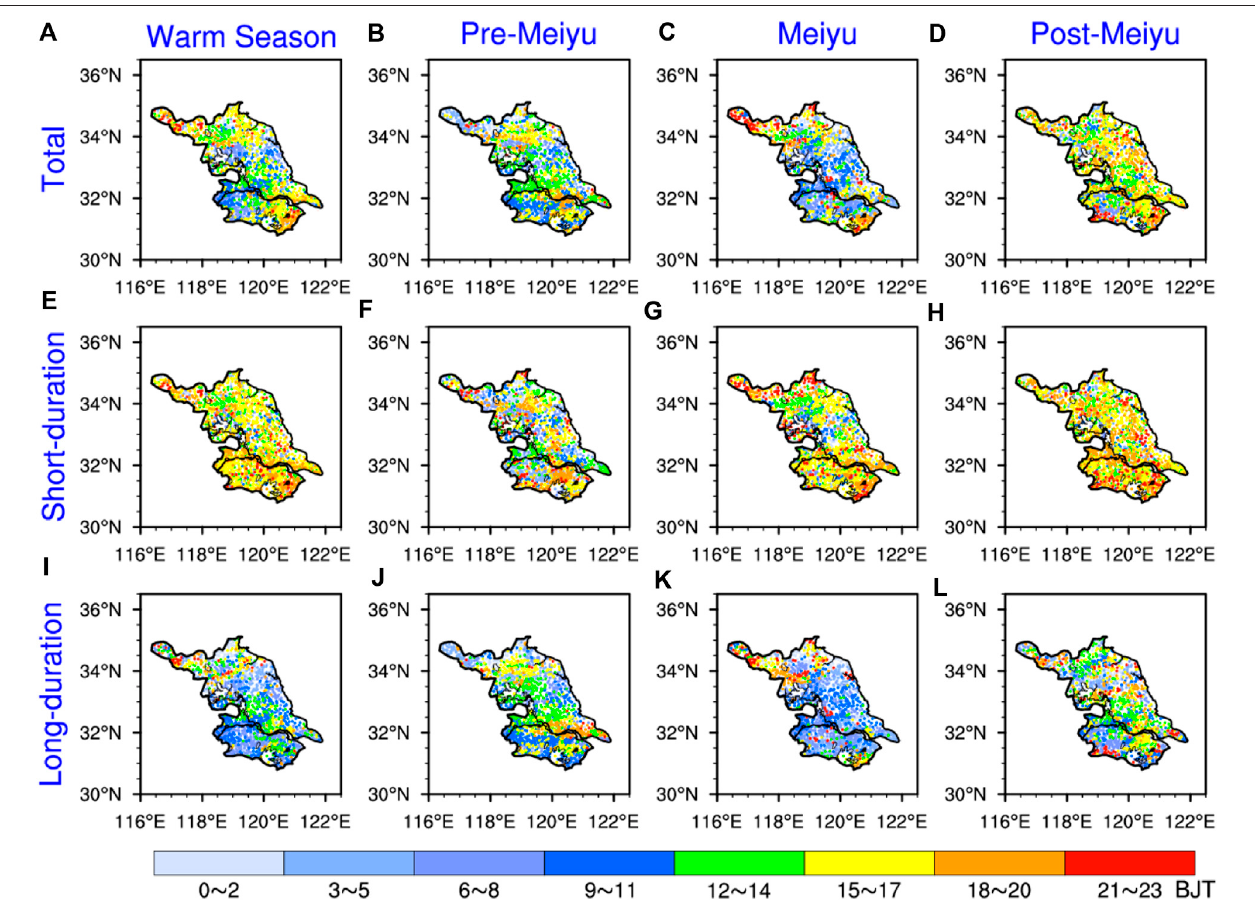
FIGURE9| SpatialdistributionsofthediurnalpeaktimeofPAfortotalrainfall (A-D) ,short-durationrainfall (E-H) andlong-durationrainfall (G-I) inwarmseasonand each sub-season of warm season (four rows separately represent Warm season, Pre-Meiyu, Meiyu and Post-Meiyu period) over 2013 – 2017.